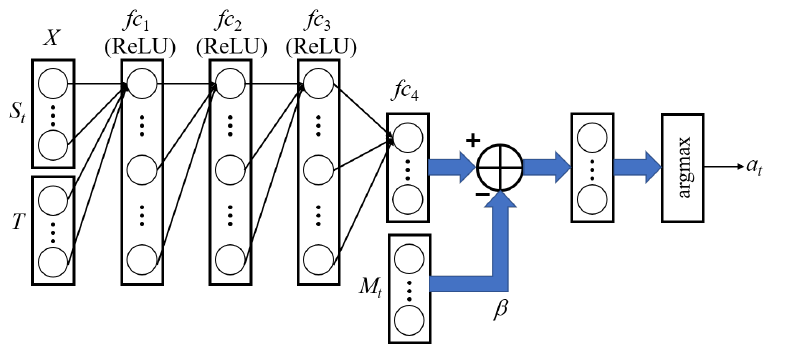
Figure 8. DQN structure. It deals with the concatenation of S t and T as an input layer. The range of S t elements from 0 to 1 is extended from − 1 to +1 in order to be matched to T .